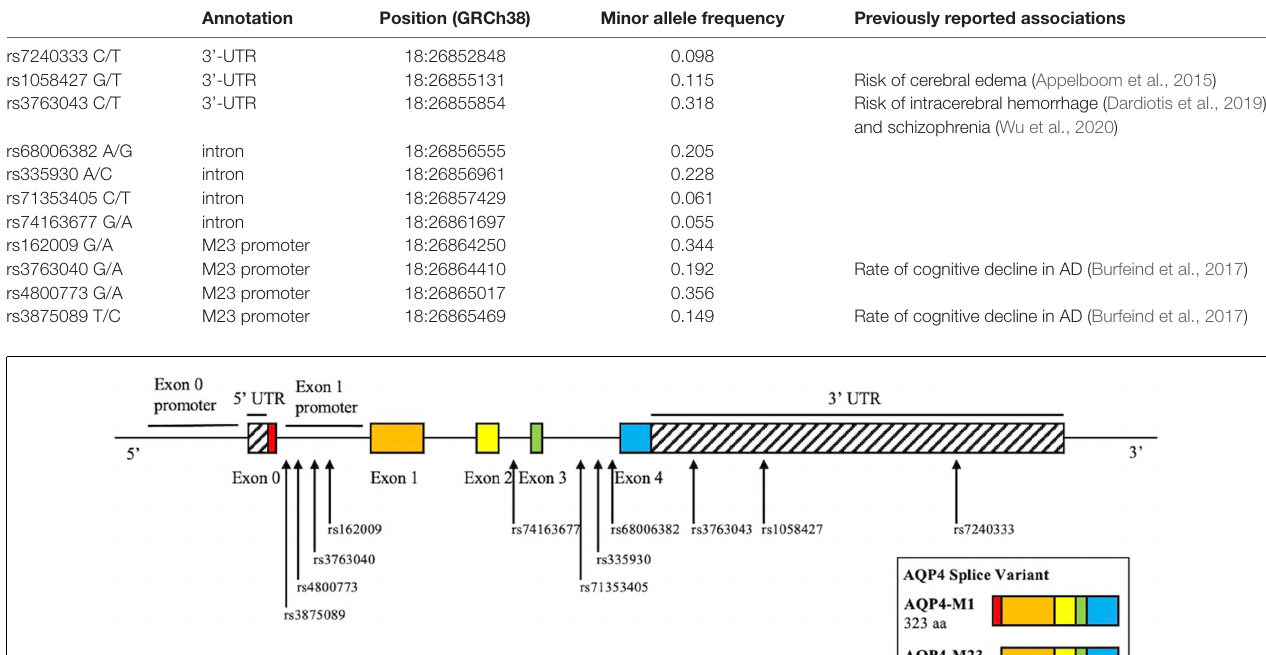
TABLE 2 | AQP4 SNPs being investigated in the current study.